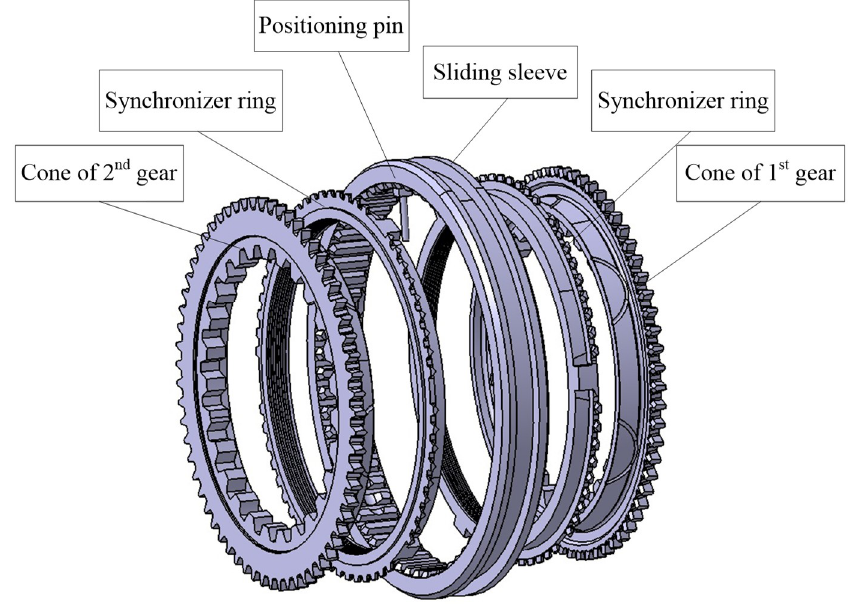
Figure 1. Composition of an inertia type synchronizer (1st and 2nd gear).